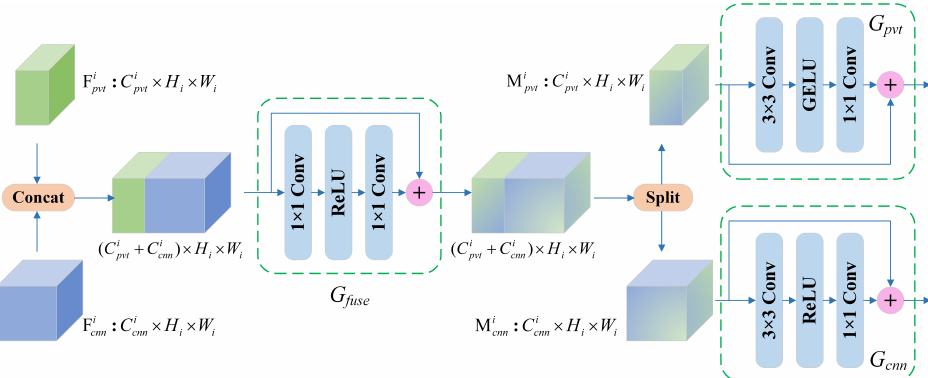
Figure 4. The structure of the feature fusion module